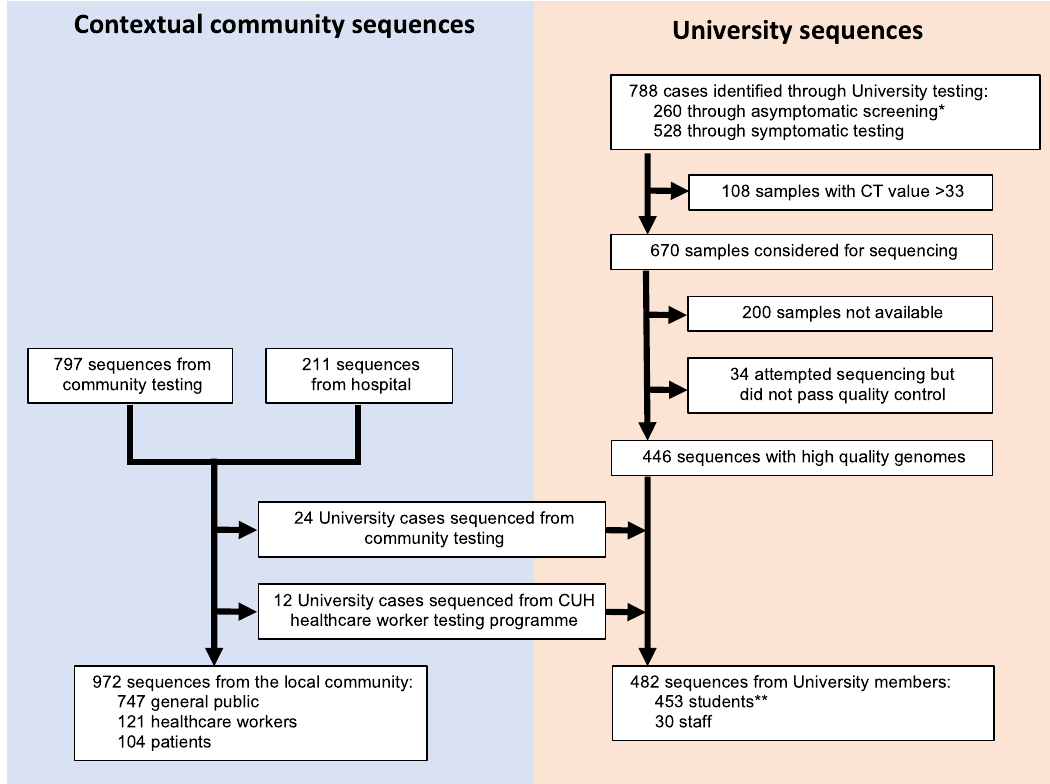
Fig. 1 Study cohort and available genome sequences. *Includes 14 students identi fi ed through ad hoc asymptomatic screening conducted as part of an outbreak investigation by the University of Cambridge in conjunction with local public health authorities, responding to increased rates of infection in a block of student accommodation (described in further detail in cluster 2 below). **Includes two students associated with a single sequenced pooled sample (see supplementary methods). CUH Cambridge University